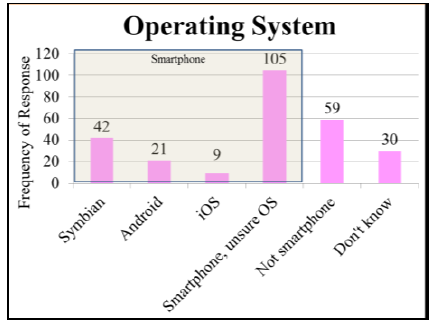
Figure 2. Operating system of owned mobile phones (Total responses = 358, no response =